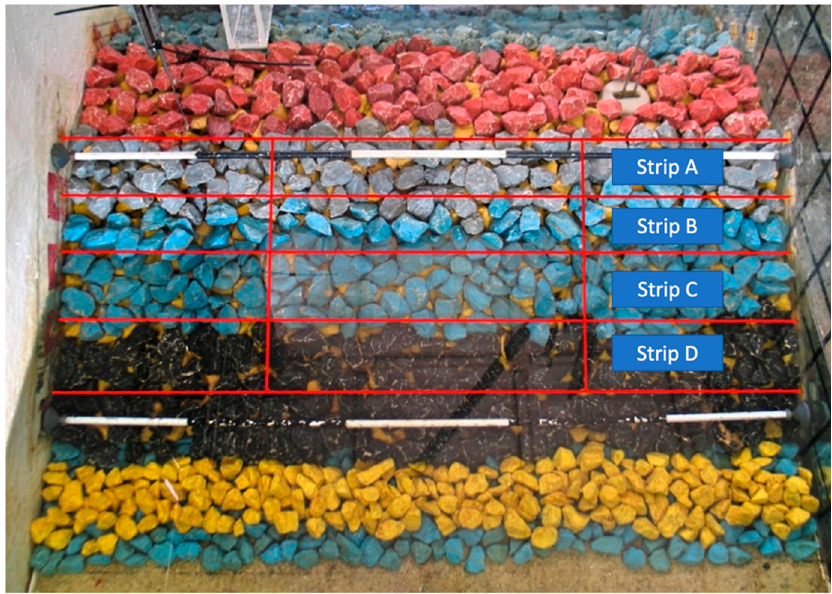
Figure 5. Application of the Virtual Net method on the front slope of rock-armored model.